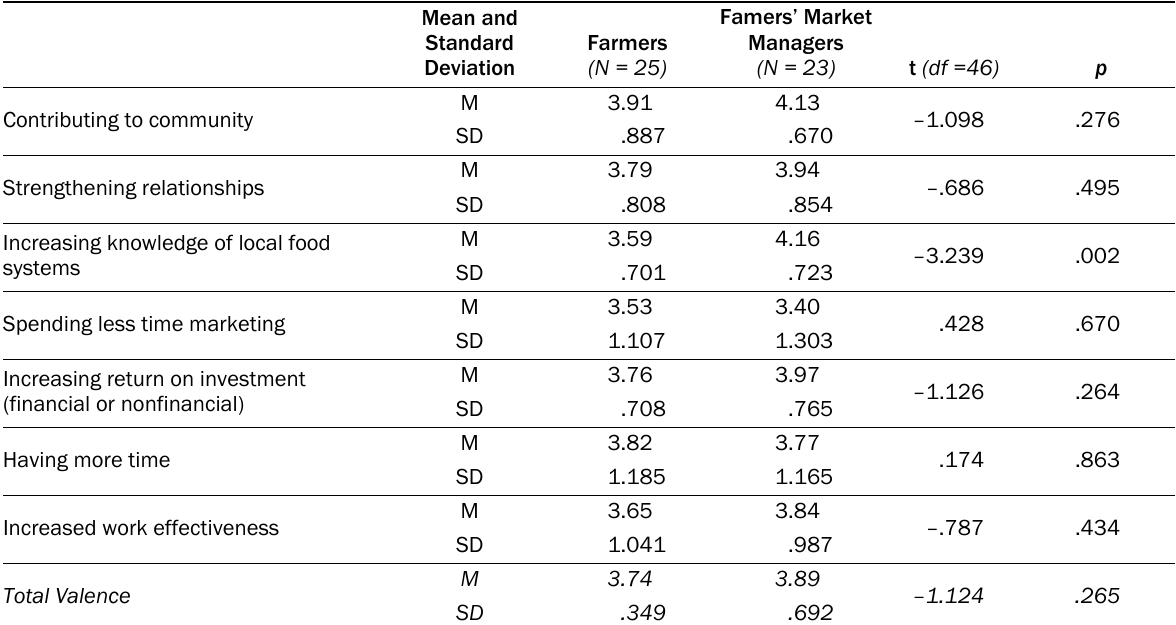
Table 5. Motivation to Collaborate: